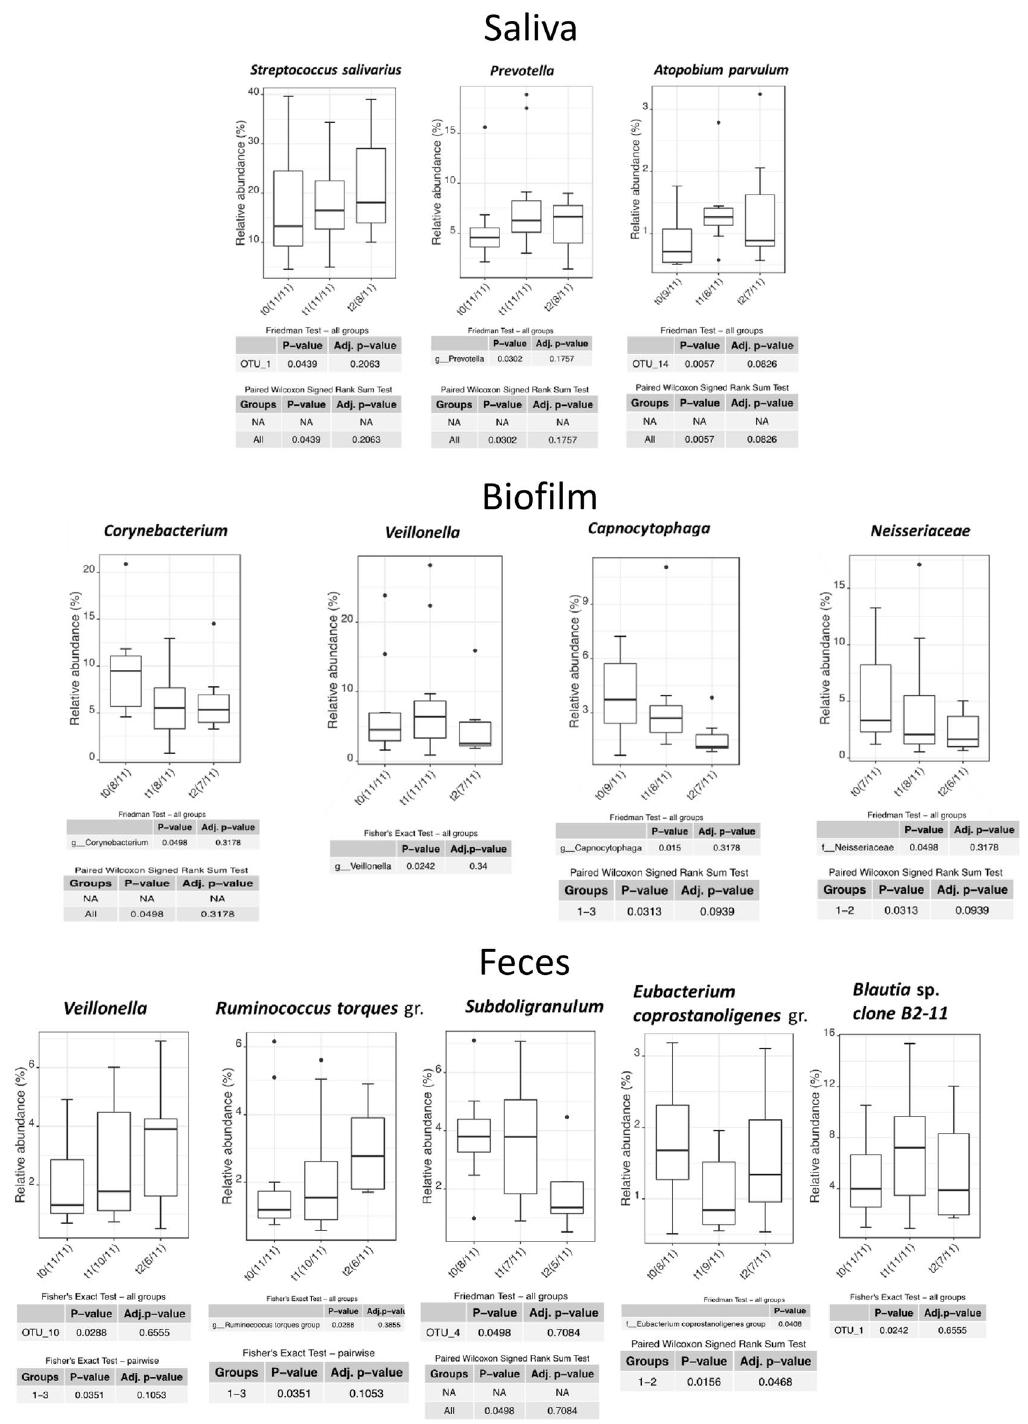
Figure 5. Statistically significant changes in certain taxa of the microbiome in saliva, biofilm, and fecal samples after